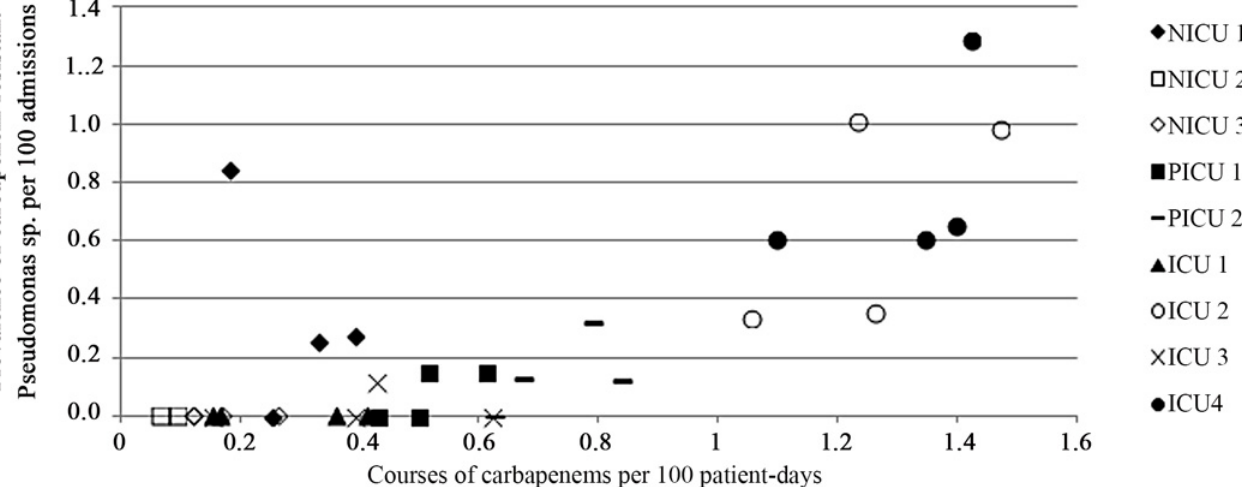
Fig 1. Scatterplot of prevalence of carbapenem-resistant Pseudomonas sp. per 100 admissions and carbapenem use in courses per 100 patient- days, per year and per intensive care unit (ICU).